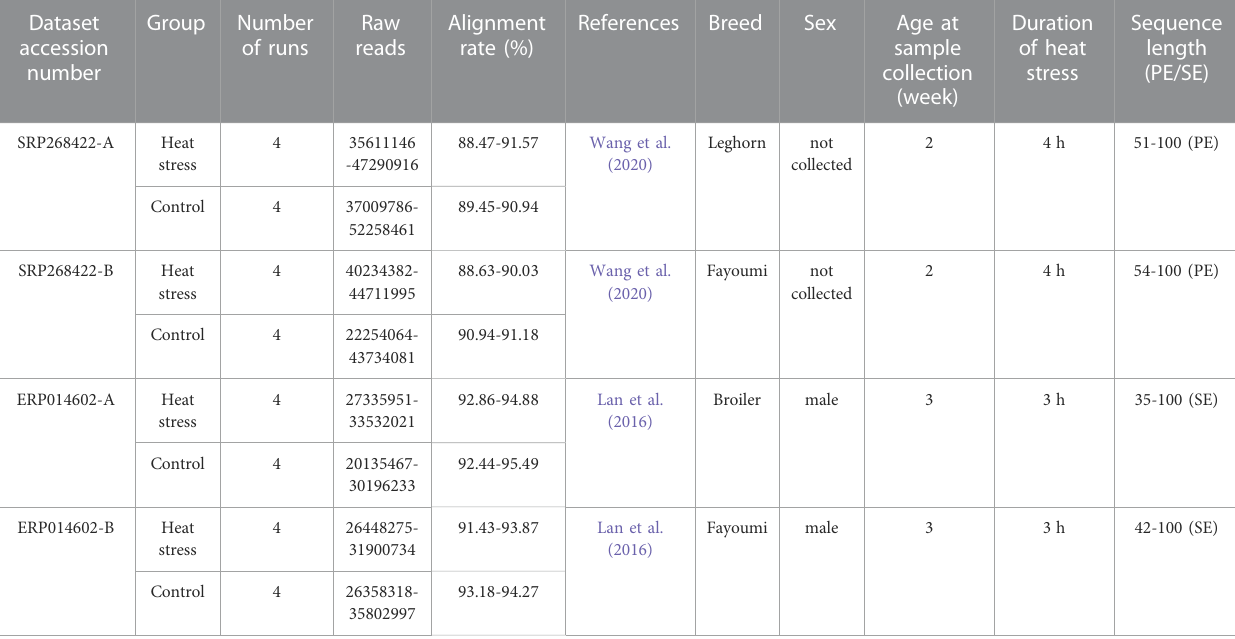
TABLE 1 Information of the used datasets for the analyses. Dataset